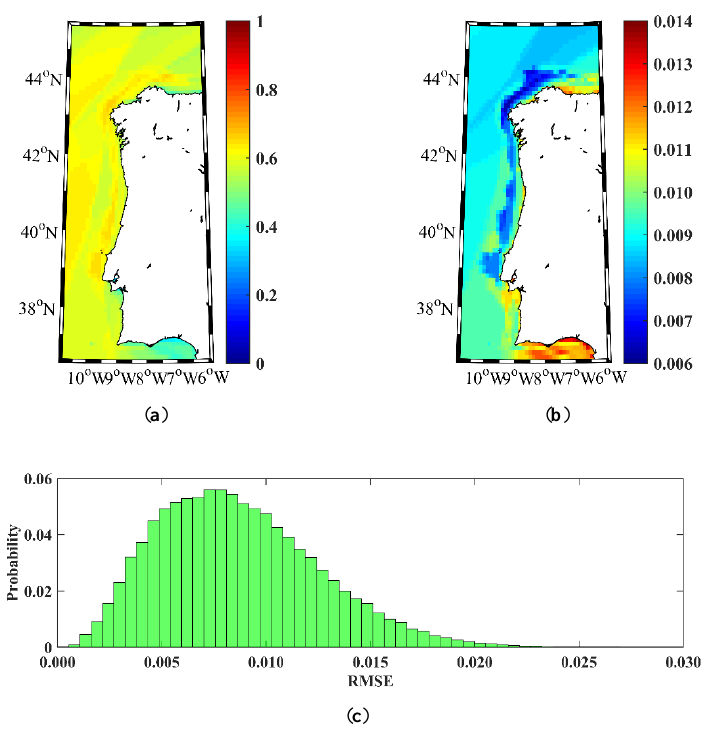
(cid:105) calculated j